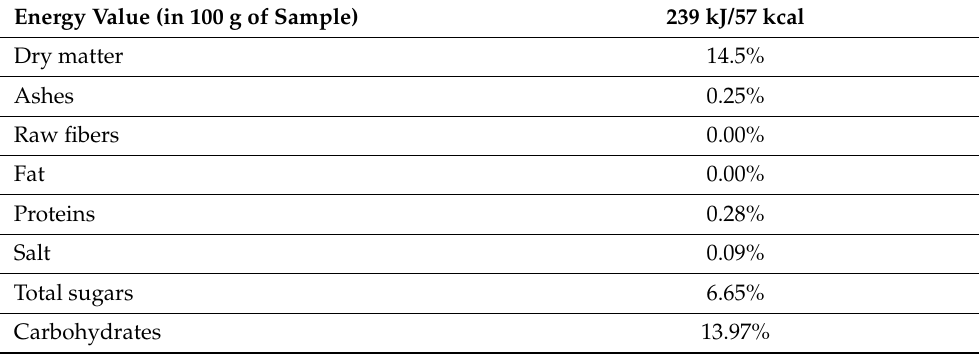
Table 5. Determined nutritive value of the best-chosen beverage, Munich malt beverage with 30% of chokeberry